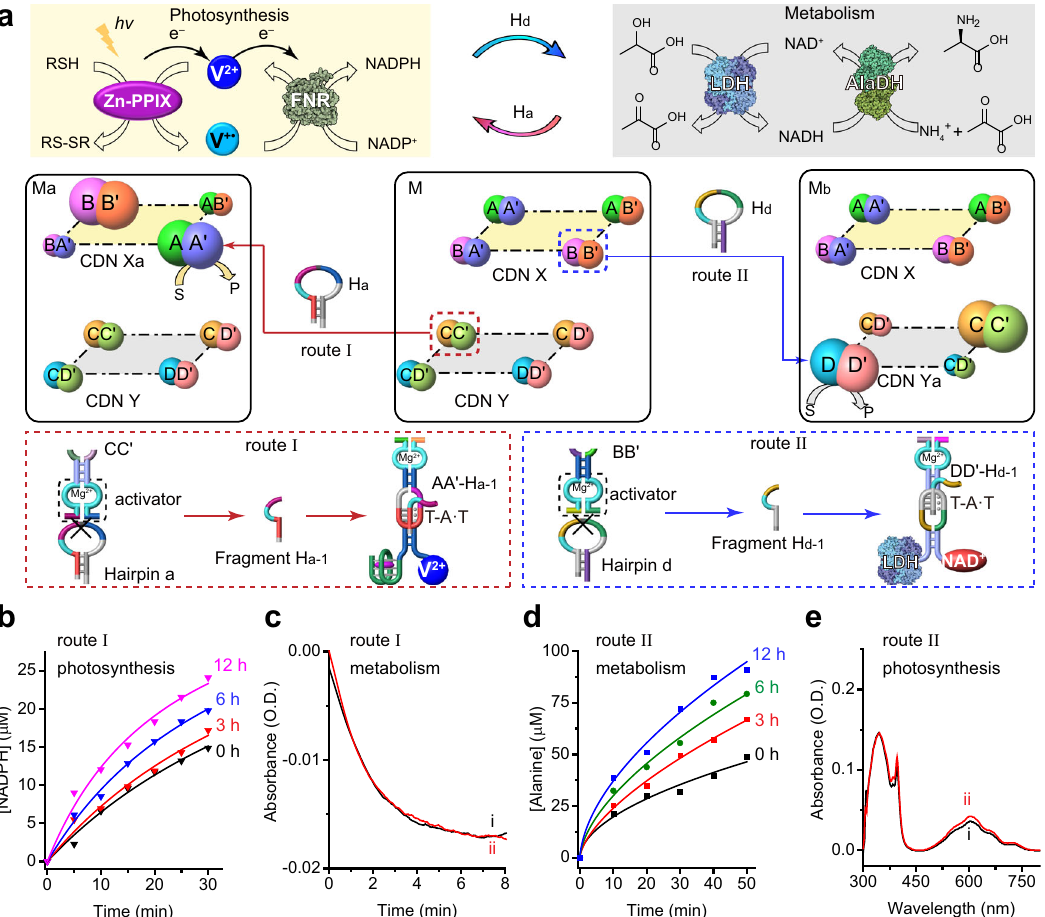
Fig. 3 Intercommunication between the photosynthetic network (X) and the metabolic network (Y) using hairpin stimulants. a The mixture M consisting of constitutional dynamic networks CDNs X and Y subjected to the stimulant H a leads to CDN Y-driven transition of the mixture into state M a that includes CDN X a and unaffected CDN Y. The cleavage of hairpin a (H a ) by CC ′ of CDN Y leads to a fragmented strand H a-1 that stabilizes AA ′ , resulting in the recon fi guration of CDN X into X a (route I). Subjecting mixture M to hairpin d (H d ) leads to the photosynthetic network-guided transition of M into M b through the cleavage of H d by BB ′ and the generation of a fragmented strand H d-1 that stabilizes DD ′ , while CDN X is unaffected (route II). S and P represent substrate and product, respectively. b Time-dependent formation of reduced nicotinamide adenine dinucleotide phosphate (NADPH) by the photosynthetic network at time intervals of treatment of mixture M with the stimulant H a . For duplicate results in b , see Supplementary Fig. 23. c Time- dependent reduction of methylene blue by the metabolic network: (i) before and (ii) after treatment of mixture M with the stimulant H a . d Time-dependent formation of L -alanine by CDN Y at time intervals of treatment of mixture M with the stimulant H d . For duplicate results in d , see Supplementary Fig. 25. e Absorbance spectra of photosynthesized NADPH by CDN X: (i) before and (ii) after treatment of mixture M with the stimulant H d . N = 2 independent experiments were performed. Source data are provided as a Source Data fi